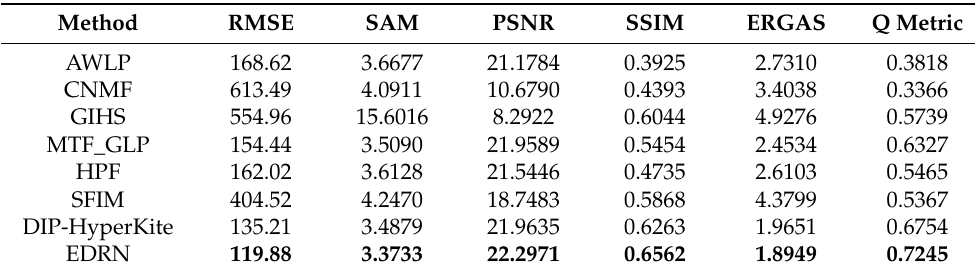
Figure 17. Quality of the compared and proposed fusion methods on the Chaohu dataset: ( a ) SCC; ( b ) spectral curve comparison. Table 2. Quality of the compared and proposed fusion methods on the Chaohu dataset for RMSE, SAM, PSNR, SSIM, ERGAS and the Q